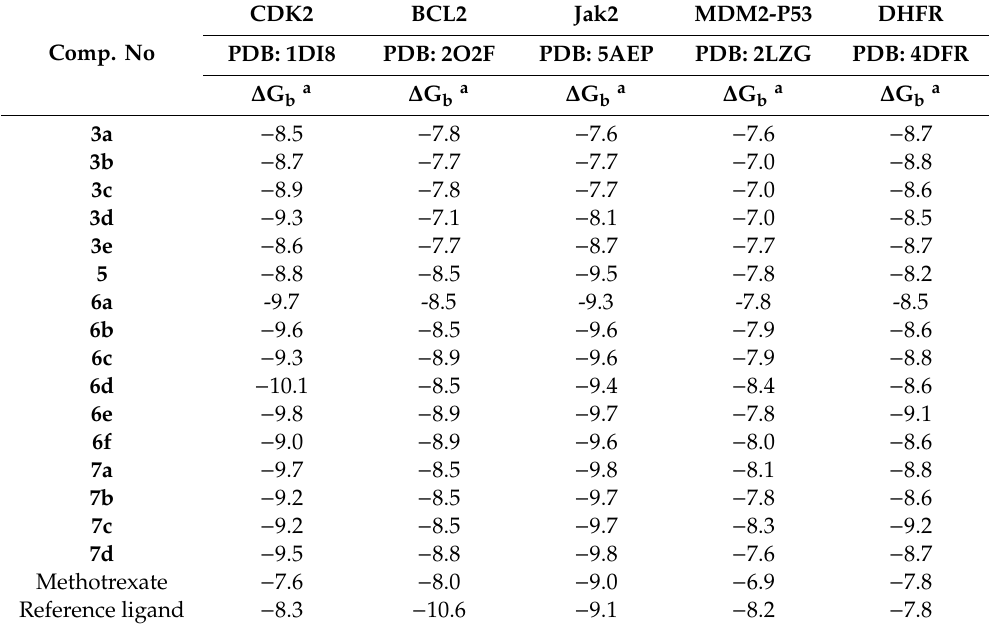
Table 2. Binding Free energy for the tested compounds against docked proteins (CDK2, BCL2, Jak2, MDM2-P53, and DHFR) binding pockets in comparison to the co-crystallized ligands and methotrexate.